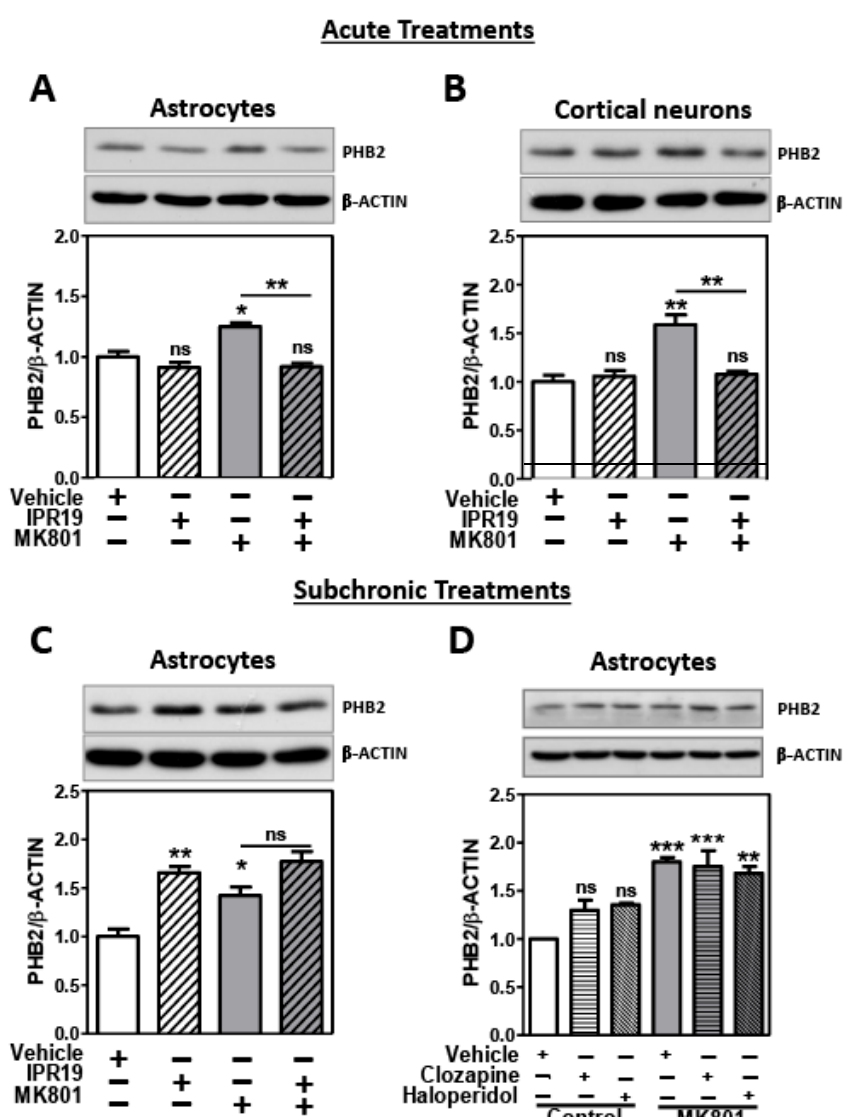
Figure 3. PHB2 protein levels were regulated by the POP inhibitor (IPR19) in both cortical neurons and astroglial-enriched cultures acutely treated with MK-801: Representative immunoblot images for PHB2 and β -actin in untreated and treated cells are shown. Each bar represents the mean and the standard error of the mean for each group for PHB2 normalized to β -actin. PHB2 protein levels from astroglial-enriched cultures ( A ) and cortical frontal neurons ( B ) acutely treated with vehicle (DMSO), N-methyl-D-aspartate receptor antagonist MK801 (10 µ M MK801), prolyl oligopeptidase inhibitor IPR19 (50 µ M IPR19), or the combination of both inhibitors (MK801 and IPR19) for 35 min. ( C ) PHB2 protein levels from astroglial-enriched cultures subchronically treated with DMSO, 50 µ M MK801, 50 µ M IPR19, or the combination of both inhibitors (MK801 and IPR19) during 72 h. ( D ) Astroglial- enriched cultures cultured and treated with MK801 or vehicle (DMSO) together with 10 µ M clozapine or 1 µ M haloperidol for 72 h. Statistical analysis was performed using one-way ( A – C ) or two- way ( D ) ANOVA followed by post hoc comparison between untreated condition and different treatments and the indicated comparison with MK801 group. (* p < 0.05; ** p < 0.01; *** p < 0.001; ns, not